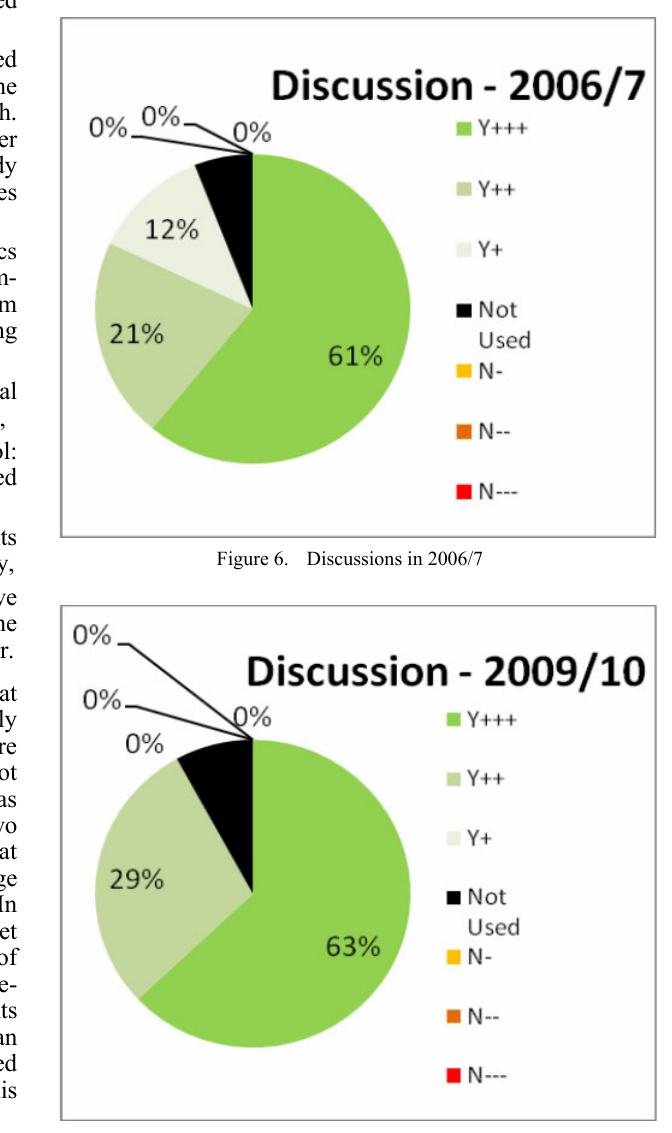
Figure 7. Discussions in